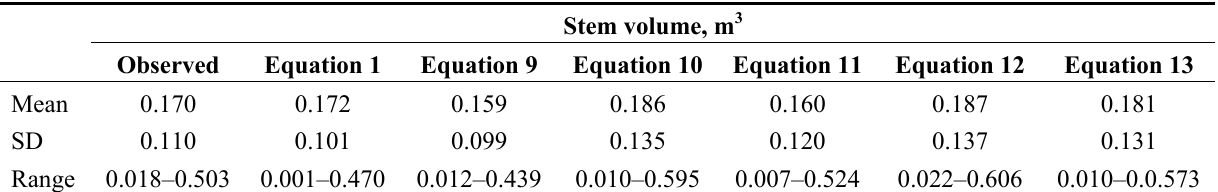
Table 3. Comparison of observed stem volumes for Norway spruce between the constructed Equation 1 and Equations 9–13.